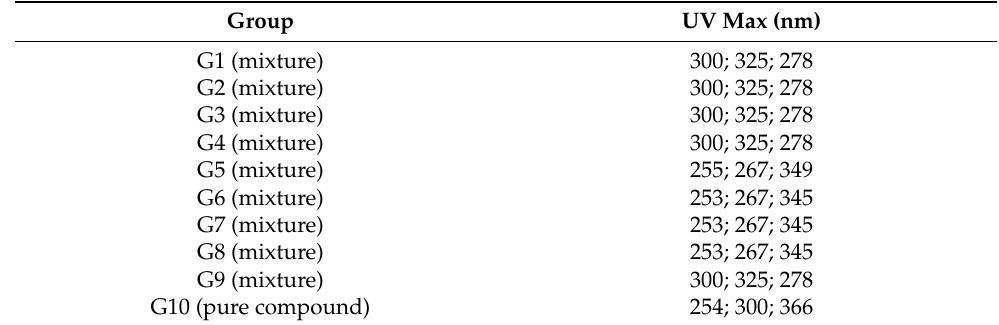
Table 1. Data taken from high-performance liquid chromatography with photodiode array detector analyses of fractions obtained from Bixa orellana fractions.